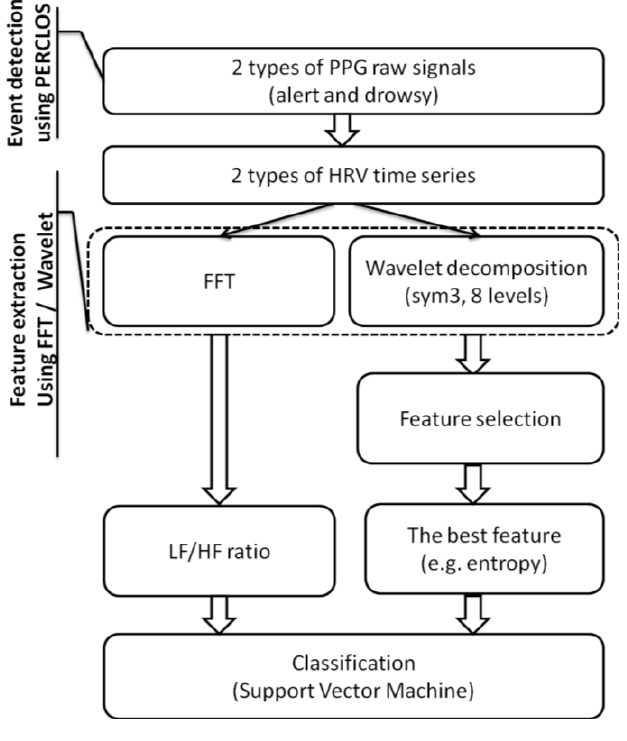
Figure 2. Flowchart of the proposed method for classifying the driver as alert or drowsy based on the PPG signal and the comparison of the FFT and wavelet analyses.